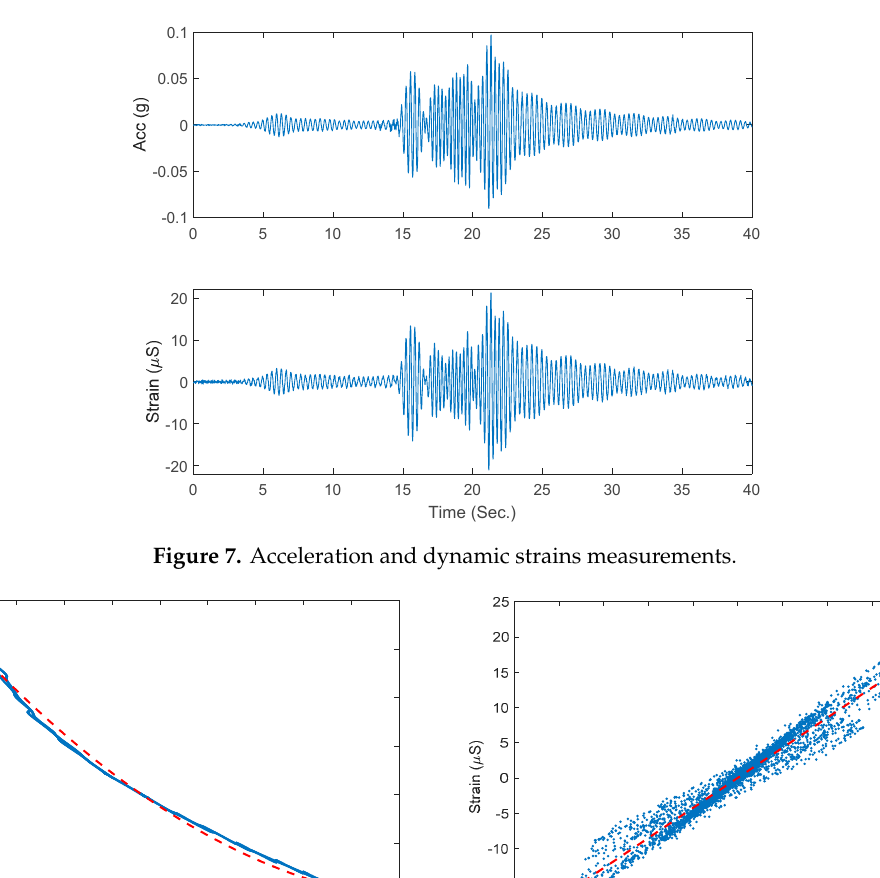
Figure 8. Scatterplot of ( a ) the semi-static strain and displacement and ( b ) the acceleration and dynamic strain.